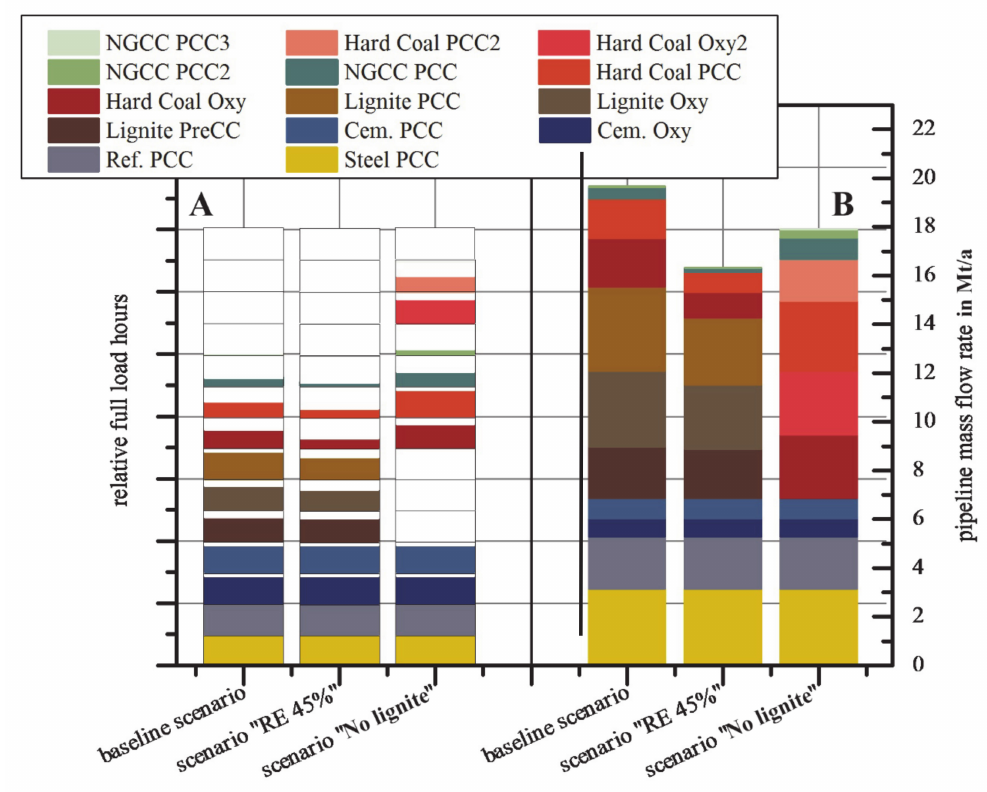
Figure 5. Relative full load hours ( A ) and pipeline mass flow rates ( B ) in the energy mix scenarios